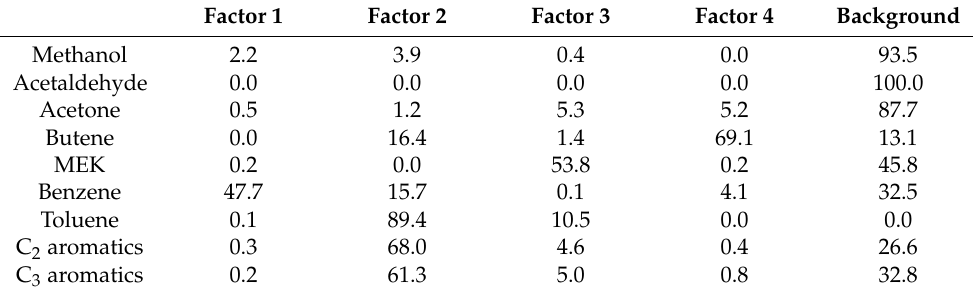
Figure 10. Apportionment of selected VOCs to the four local factors and the combined background factors averaged for periods when the vehicle was moving.